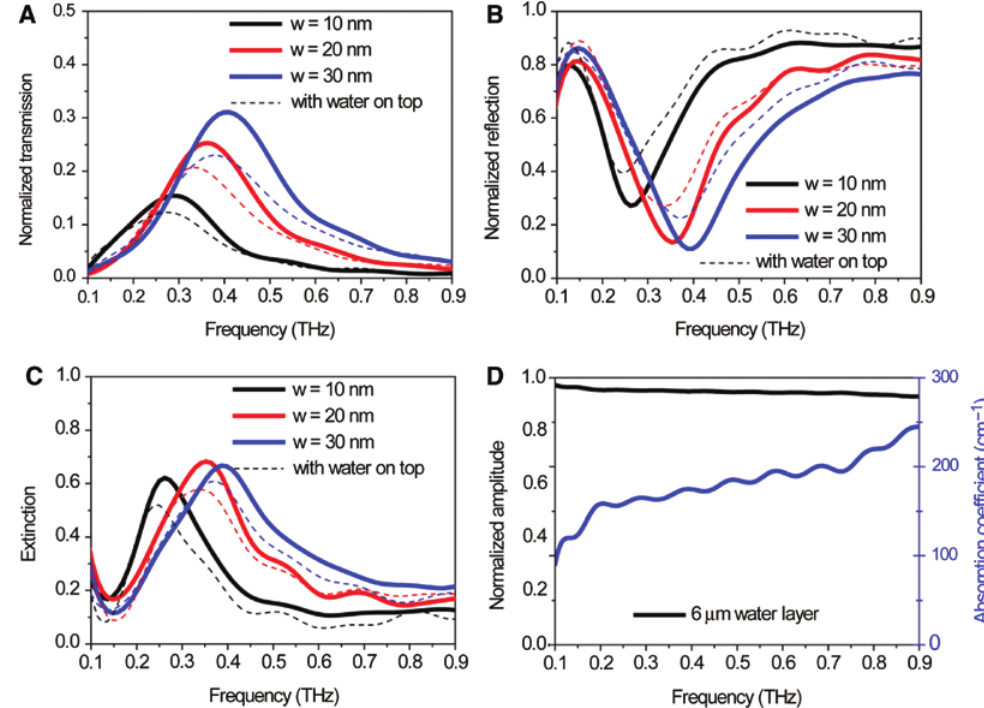
Figure 6: Substrate-side incident (A) transmission and (B) reflection data for nanogaps with and without thin water layers on top. Transmission from the nanogap-water composites are normalized with respect to that from a substrate with water layer of same thickness on top, to cancel out the effect of bulk absorption. (C) Extinction from nanogaps with and without water layer on top. (D) Transmission and absorption coefficients of 6 μ m thick water layer placed on top of the